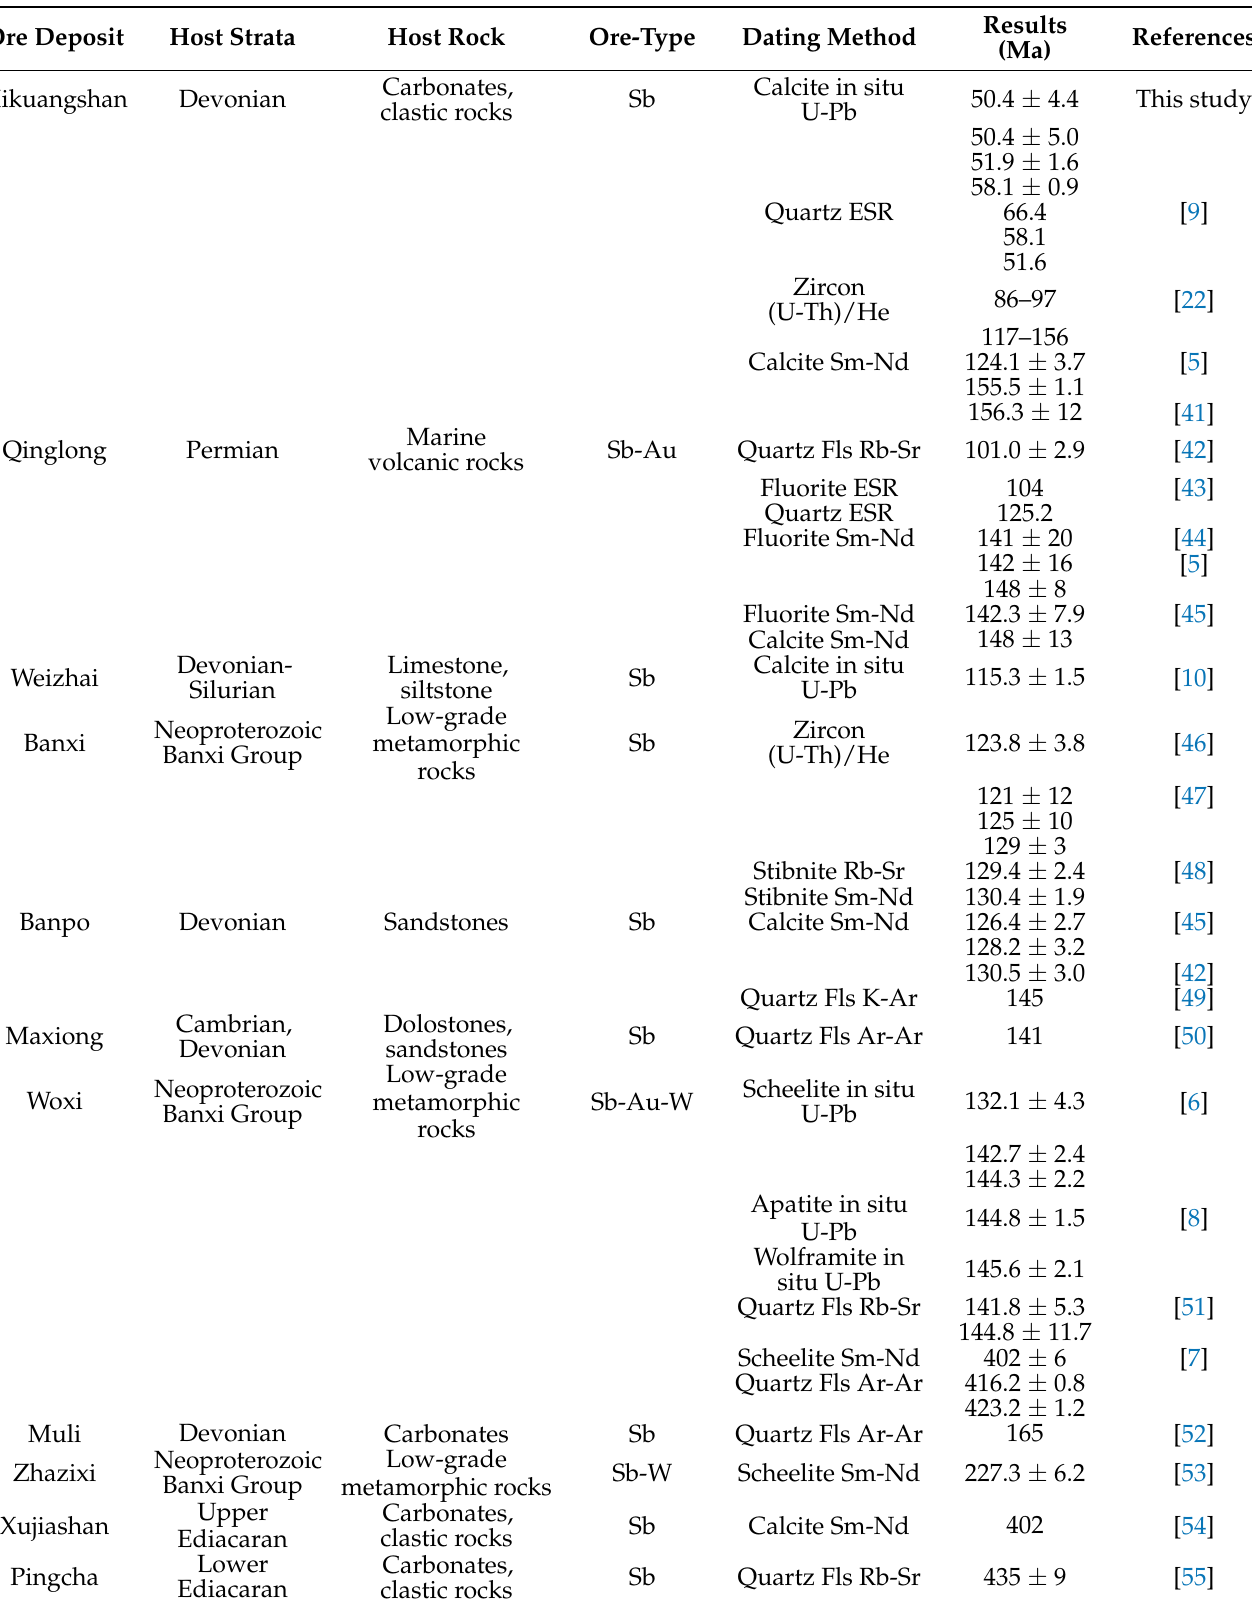
Table 1. Summary of Sb mineralization age of important Sb(-Au-W) deposits in the South China antimony metallogenic